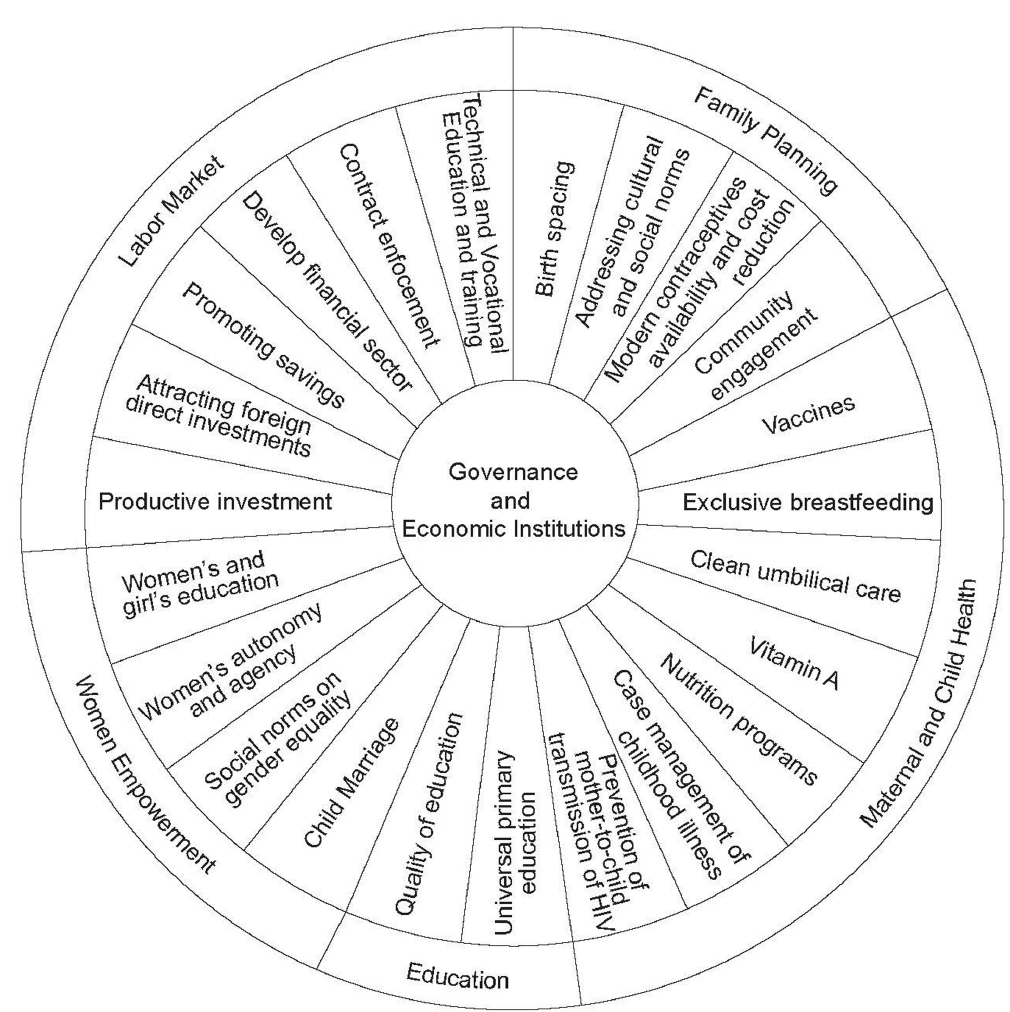
Figure 3. A demographic dividend framework, wheel of prosperity that summarizes potential sector-specific programs and interventions.